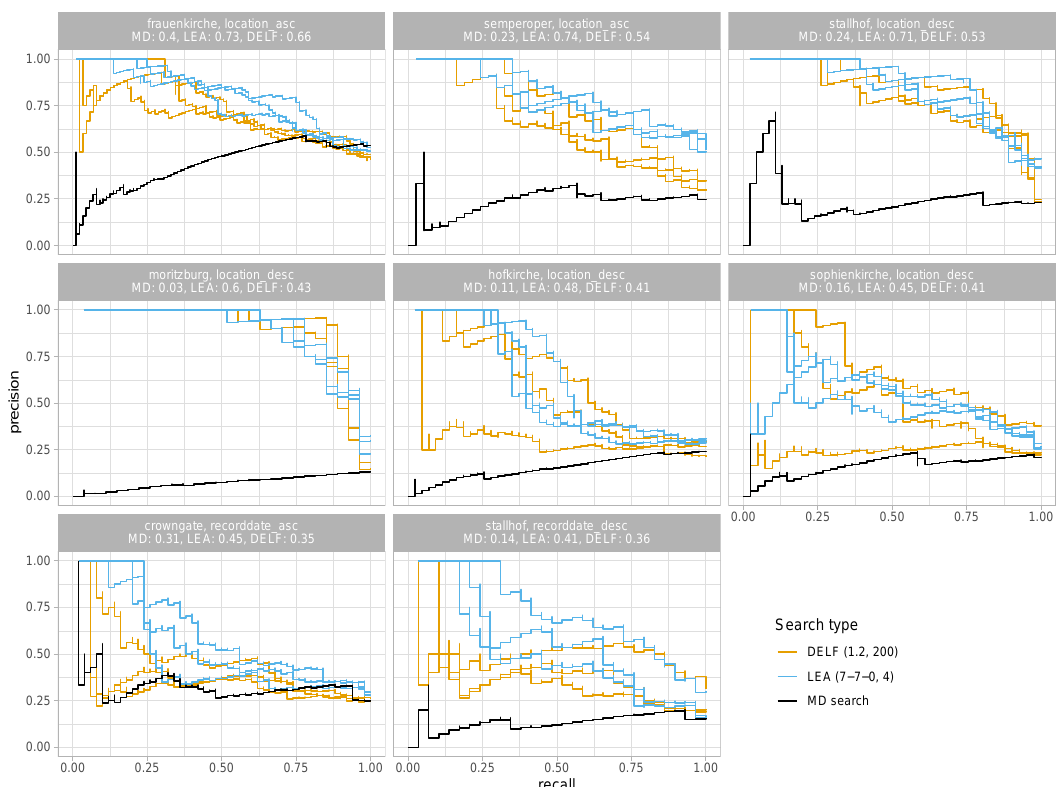
Figure 5. Selection of PR curves over all OoI for MD search and IR (LEA and DELF). Values in each subfigure refer to AP for MD search and mAP for LEA and DELF aggregating the corresponding PR